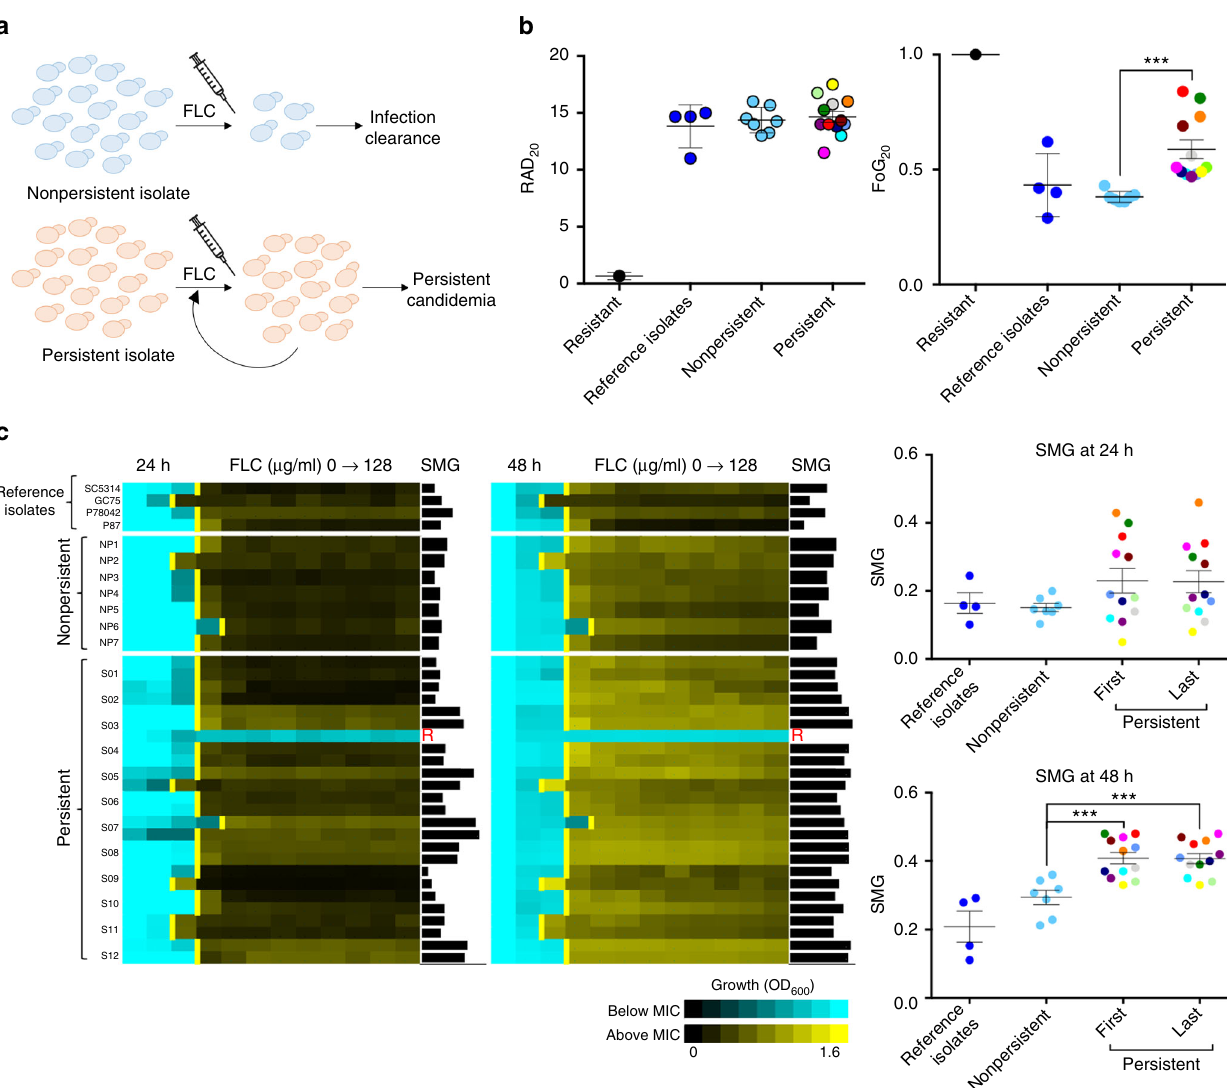
Fig. 6 FoG and SMG levels differ between persistent and non-persistent isolates. a Candida albicans isolates from bloodstream infections were either ef fi ciently cleared by a single course of FLC treatment (non-persistent) or persisted in the host despite multiple rounds of FLC therapy. b FoG and RAD levels for isolates SC5314, GC75, P78042, and P87 (reference isolates studied in Figs. 1 – 5), resistant (R, n = 1) isolate P60002 31 , the non-persistent isolates (NP, n = 7), and only the fi rst patient isolate from each of the series of clinically persistent strains (P, n = 12). Asterisks indicate signi fi cant differences between persistent and non-persistent isolates ( t test, *** P < 0.001). c Broth microdilution assays showing MIC and SMG levels at 24 and 48 h for the susceptible control strains, the non-persistent isolates as in b and for both the fi rst and last isolates for each of the 12 clinically persistent series (S01 – 12). The fi nal isolate of the S03 series of persistent strains had become FLC-resistant (MIC > 128 µ g/ml, Supplementary Fig. 10a), and therefore the penultimate isolate, which remained susceptible, was used across analyses. Asterisks indicate signi fi cant differences between persistent and non- persistent isolates ( t test, *** P < 0.001). For all panels isolates were tested in three or more biological replicates, error bars denote standard